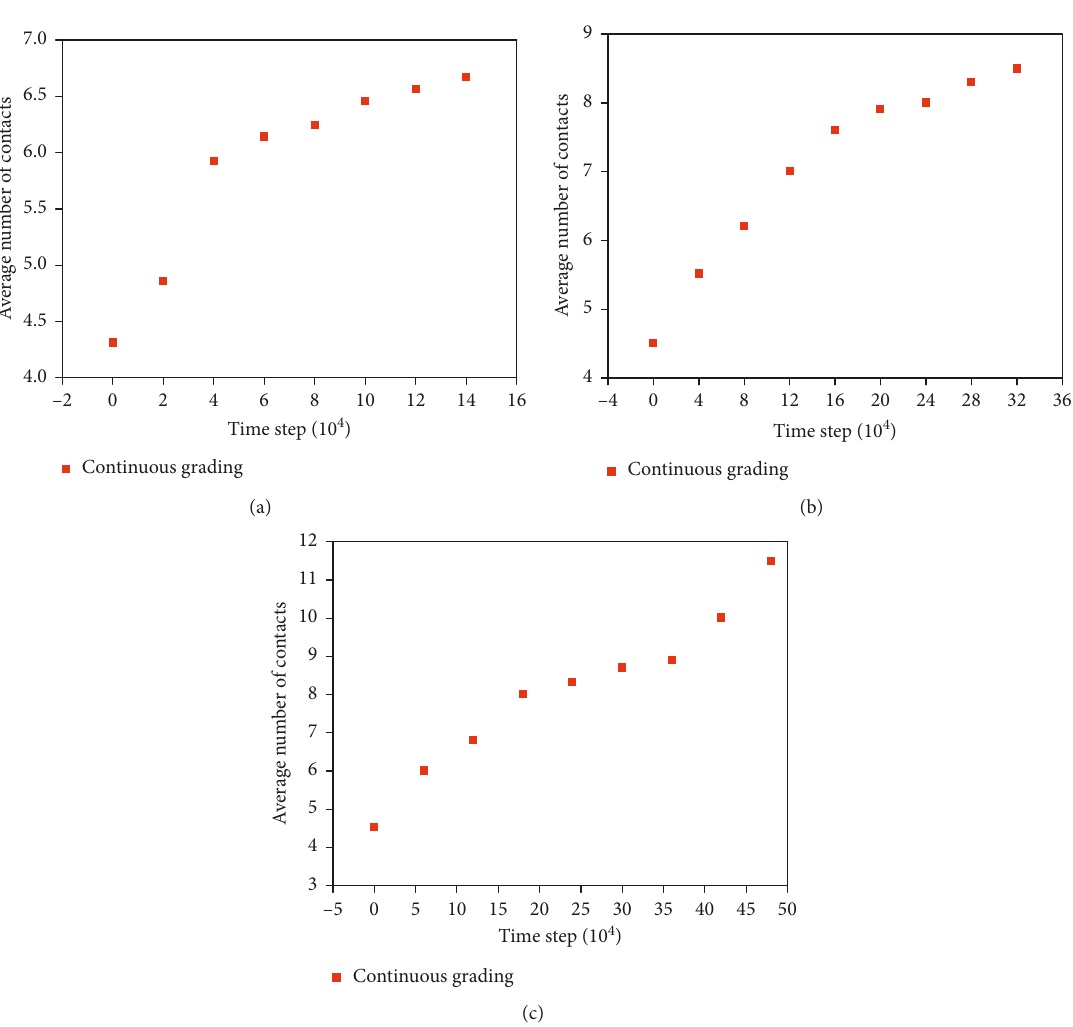
Figure 16: Variation of the average coordination numbers with different penetration displacements (a) S � 6 mm, (b) S � 12mm, and (c) S �